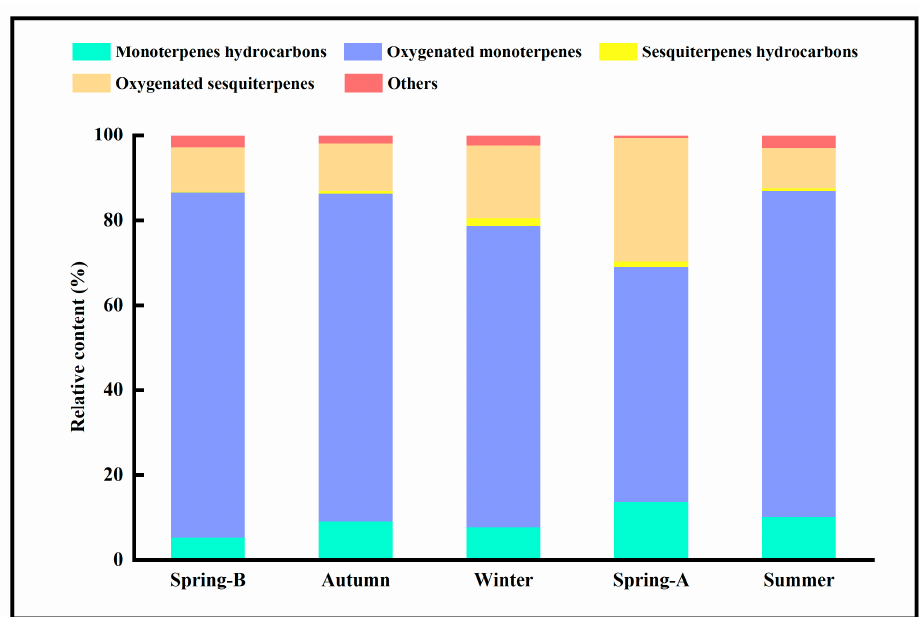
Figure 2. Seasonal variation of main component types and their relative contents in Lavandin essential oil.